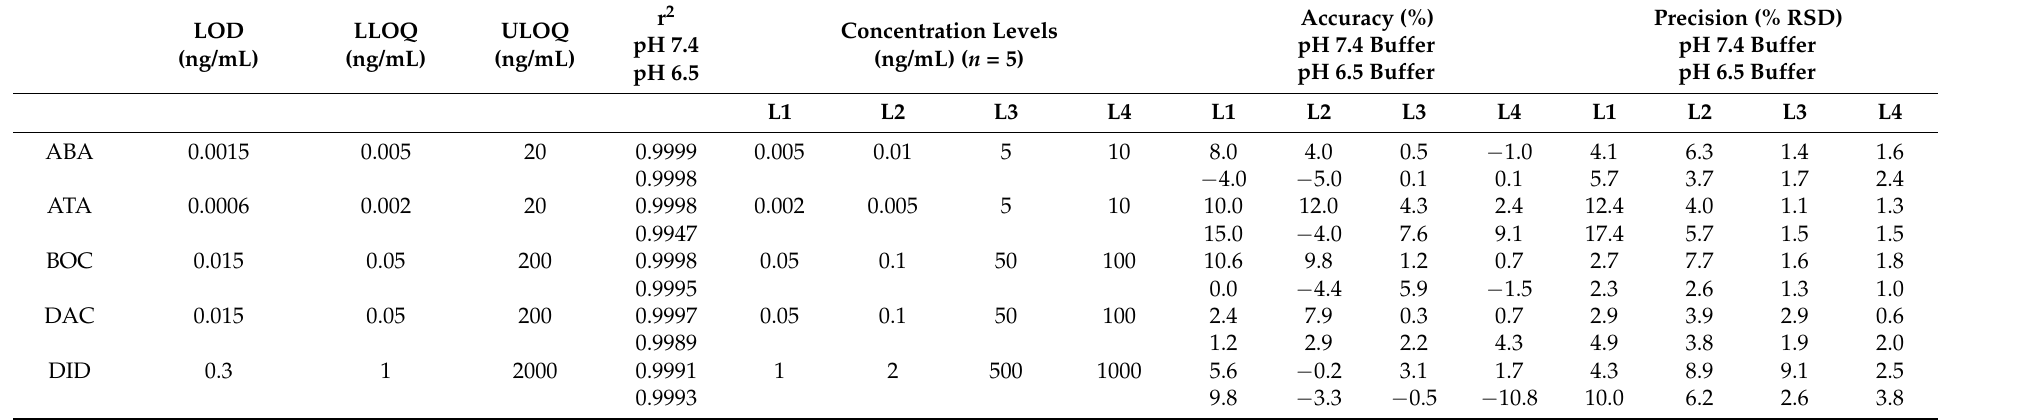
Table 3. Method validation results for